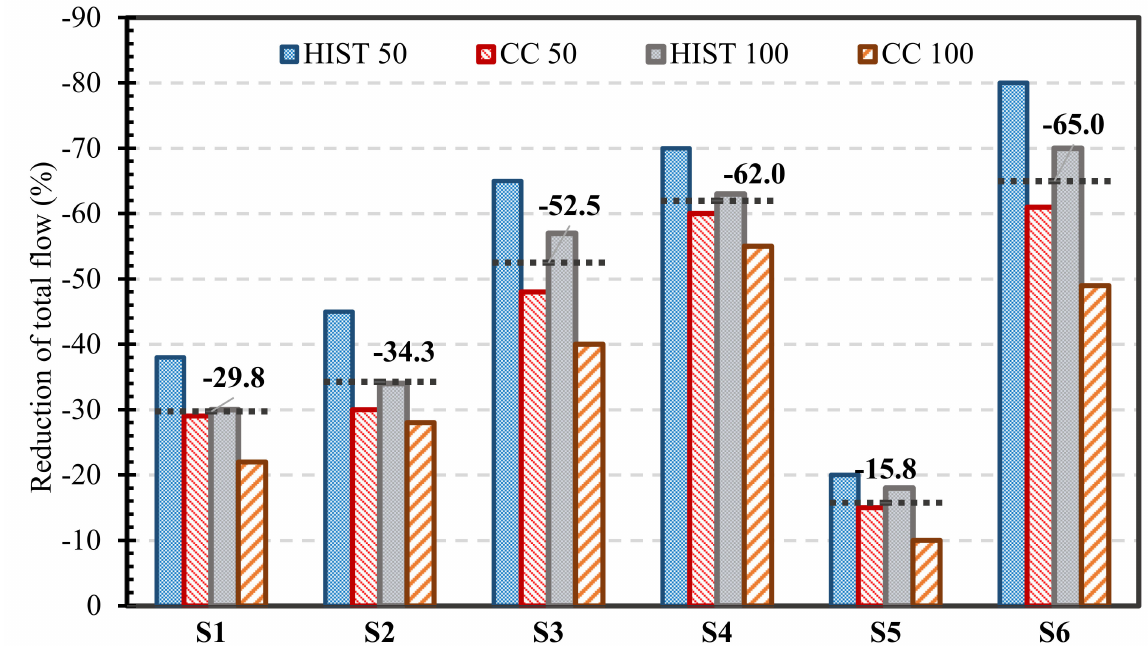
Figure 12. Reduction of total flows (%) by different LIDs scenarios for the 50- and 100-year historical (HIST) and future (CC) storm events. Dotted lines represent the reduction of flow over selected historical and future design